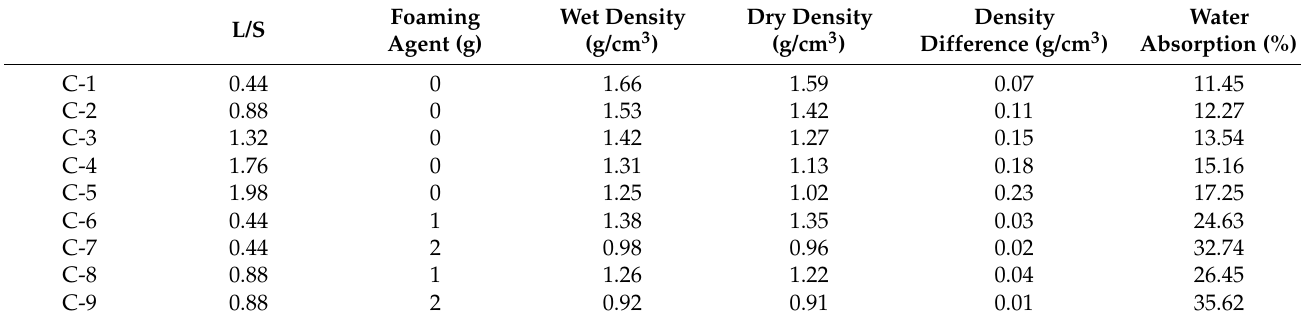
Table 4. Wet/dry density and water absorption analysis of samples.